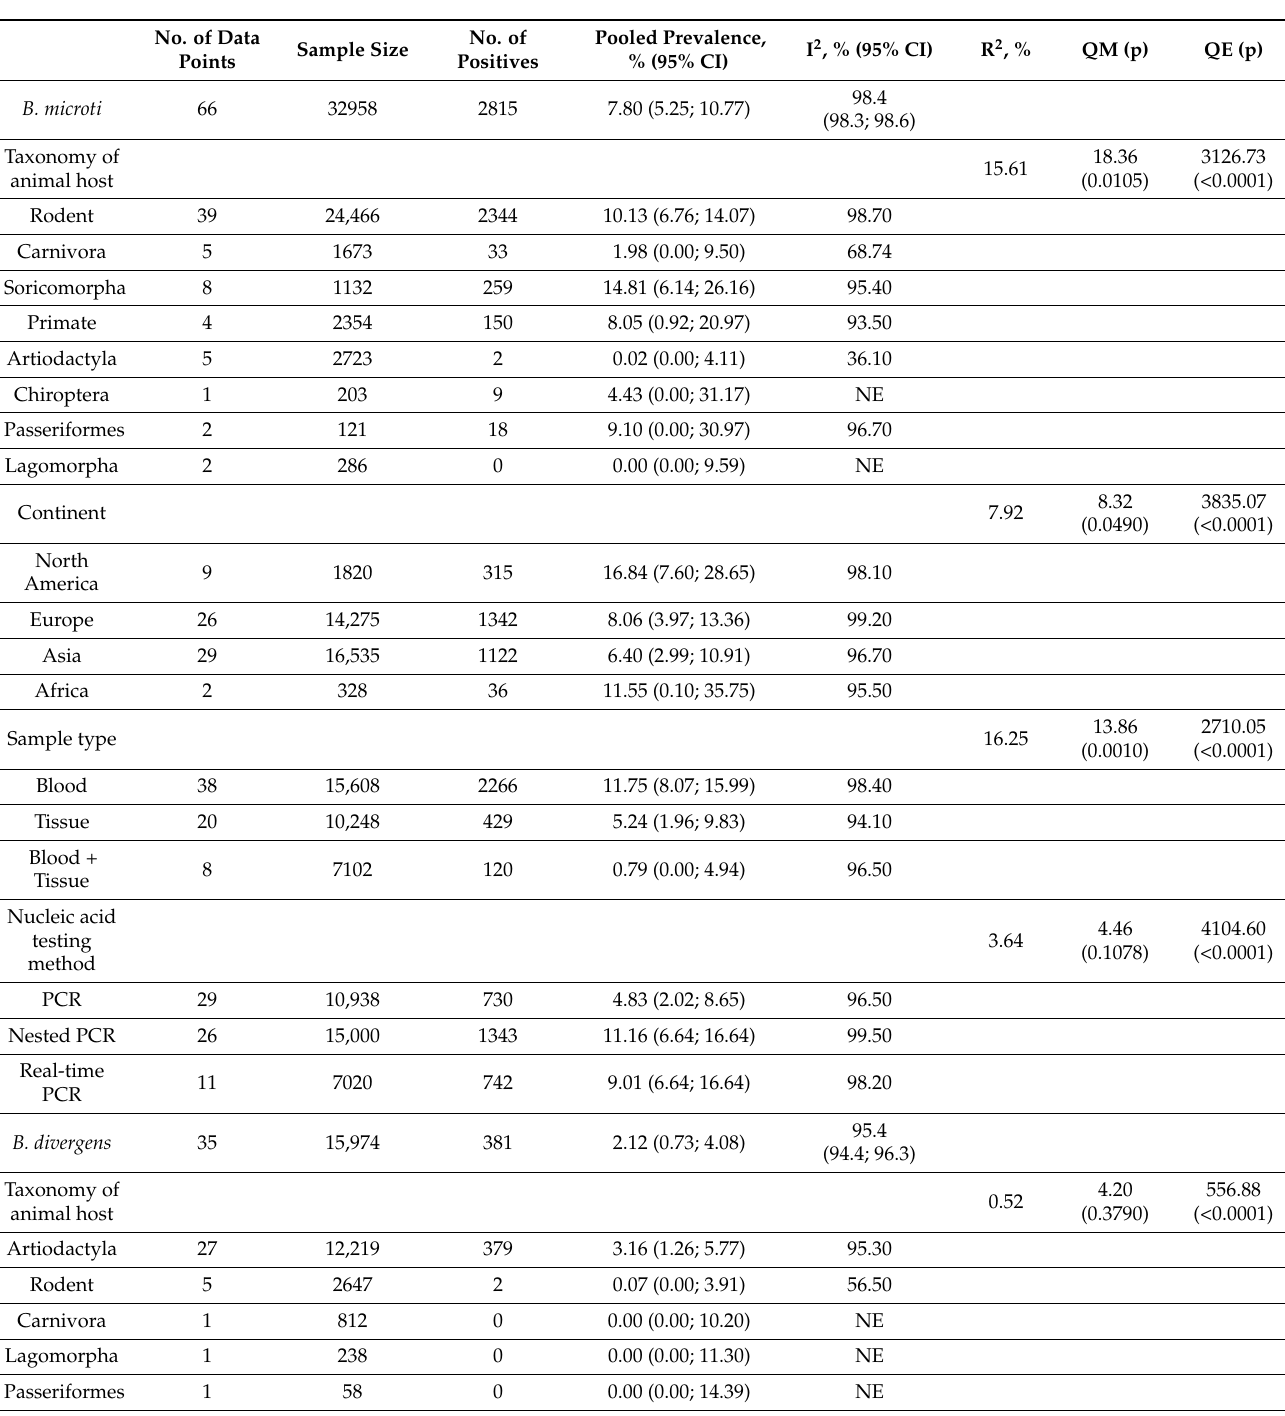
Table 2. Estimates of pooled nucleic acid prevalence and subgroup analysis of zoonotic Babesia in